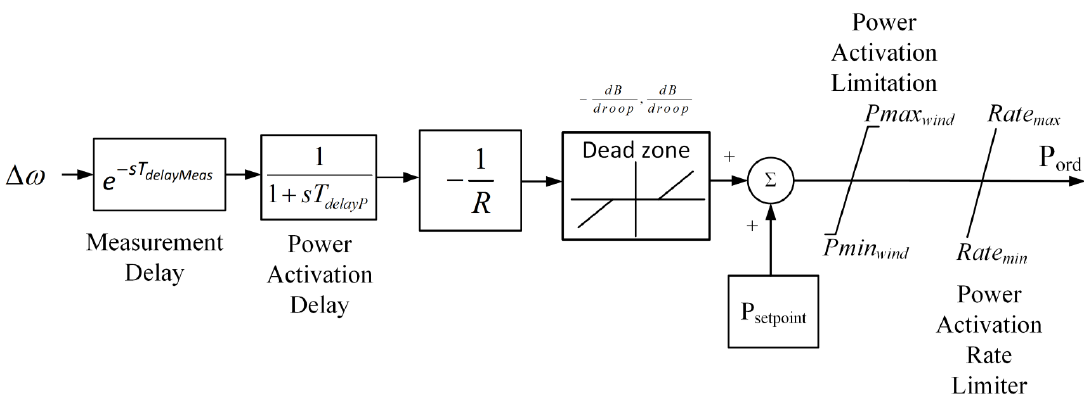
Figure 3. Frequency control model for FCP from